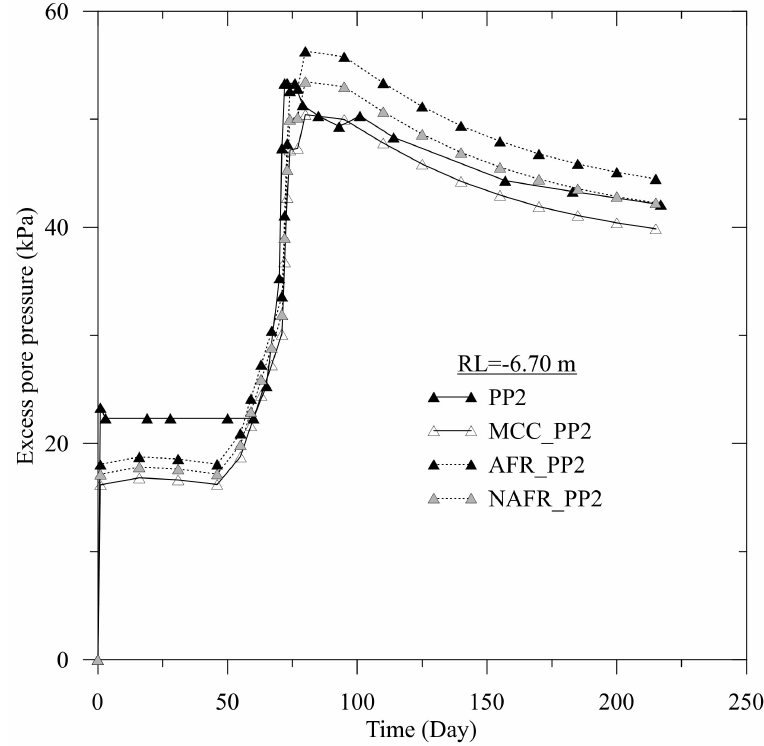
Figure 24. Observed and the predicted excess pore pressure at RL = –6.70